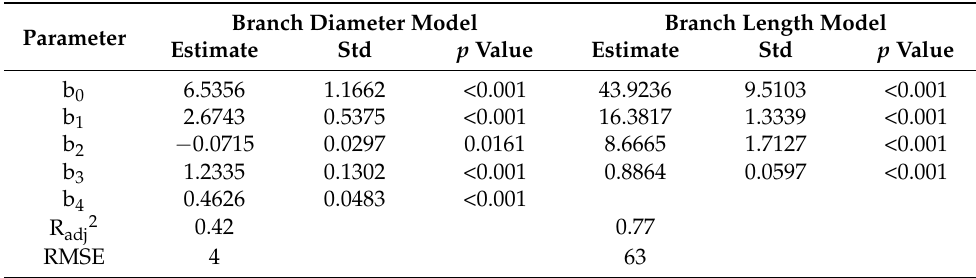
Table 5. Parameter estimates and goodness-of-fit statistics for the branch diameter and branch length model for the planted Korean pine.